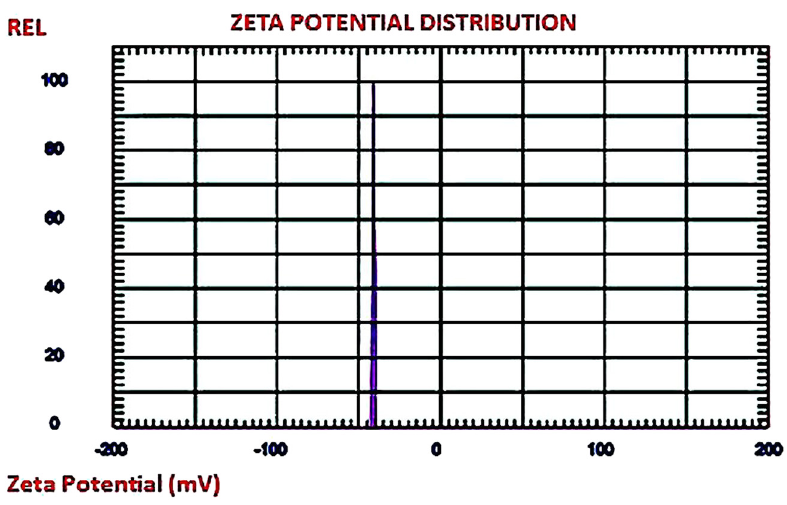
Figure A3: Zeta potential of the phytosynthesized Se - NPs with Saussurea costus extract = − 42.8 mV.